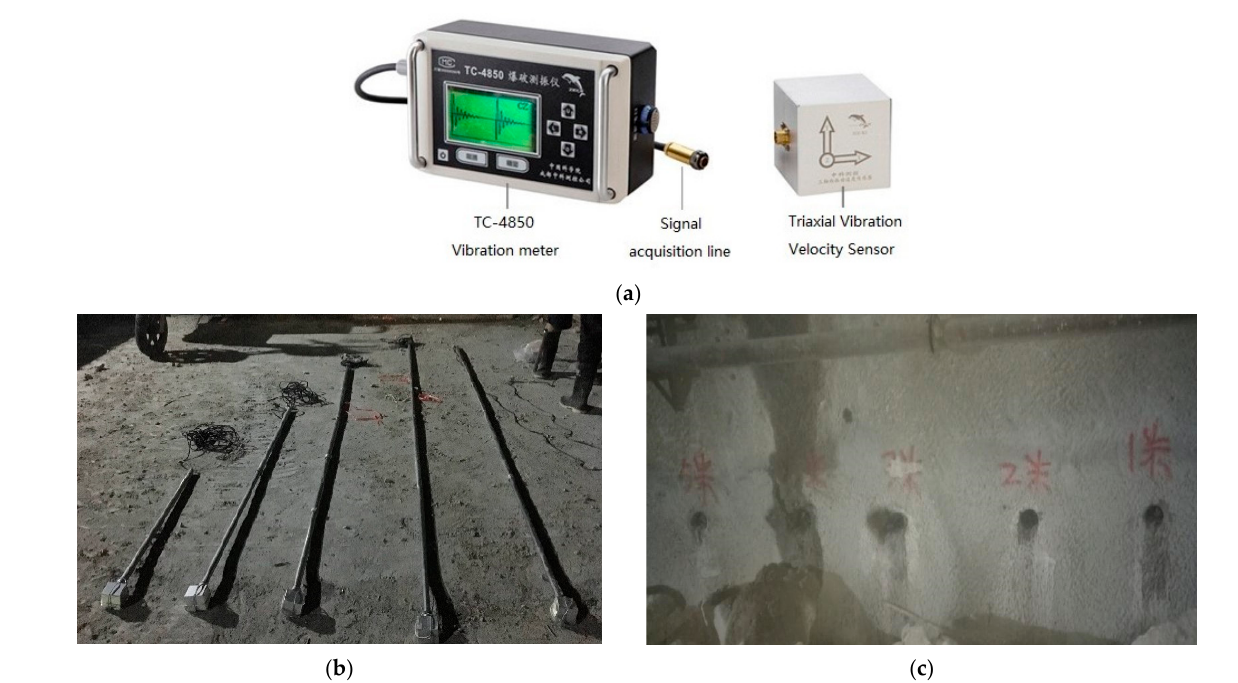
Figure 1. Layout of testing sensors and measuring points: ( a ) speed sensors; ( b ) placement of measuring points; ( c ) distribution of measuring points. Table 2. Blasting vibration monitoring